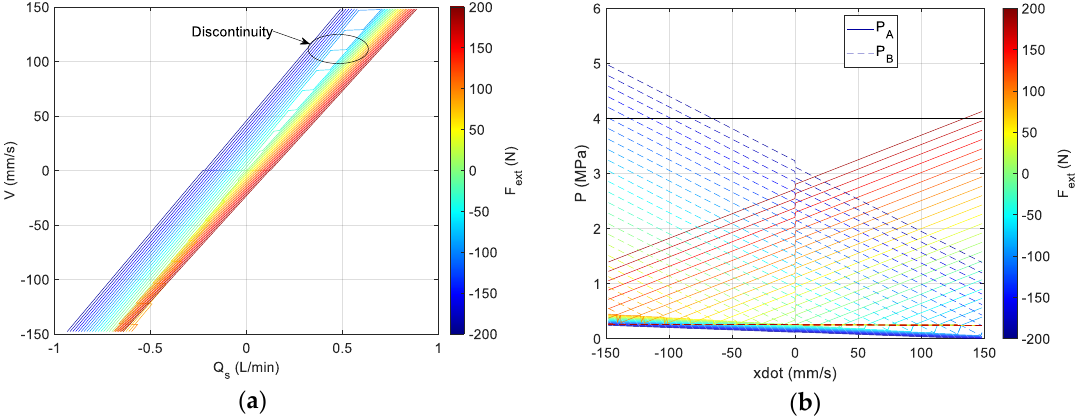
Figure 9. Calculated steady state model results for Valve B (entirely 3D printed): ( a ) actuator velocity with respect to commanded pump flow and external force. Note the labelled discontinuity in velocity; ( b ) pressures with respect to actuator velocity and external force, including the 4 MPa pressure limit and 0.25 MPa charge pressure.